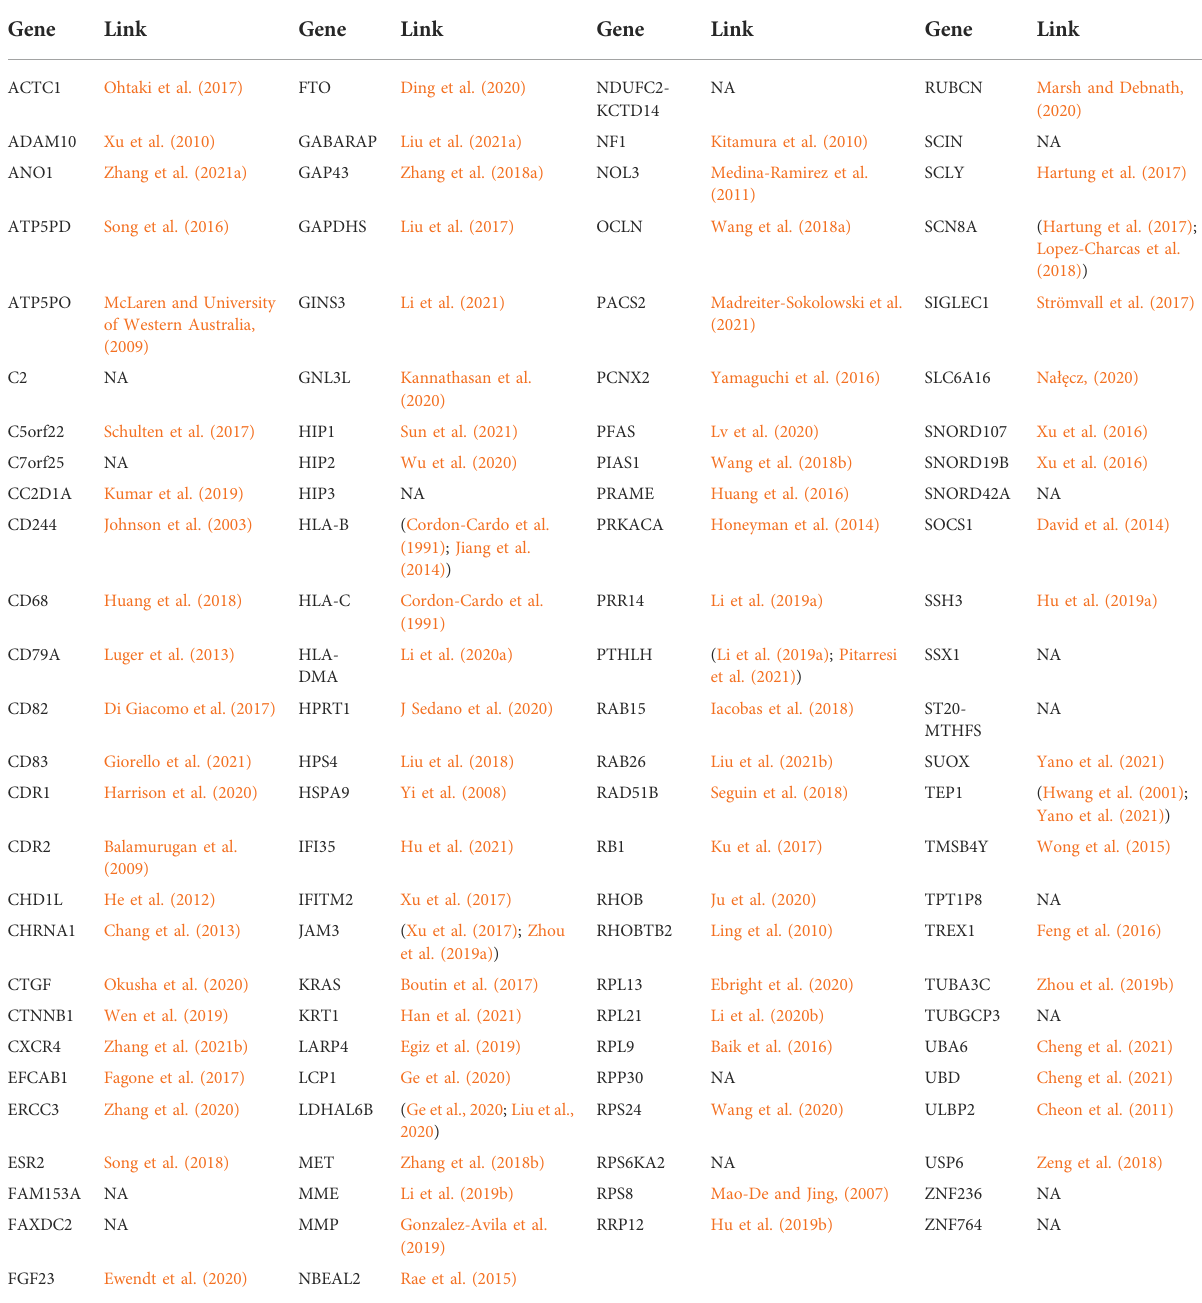
TABLE 4 Literature linking the genes used by the DL to